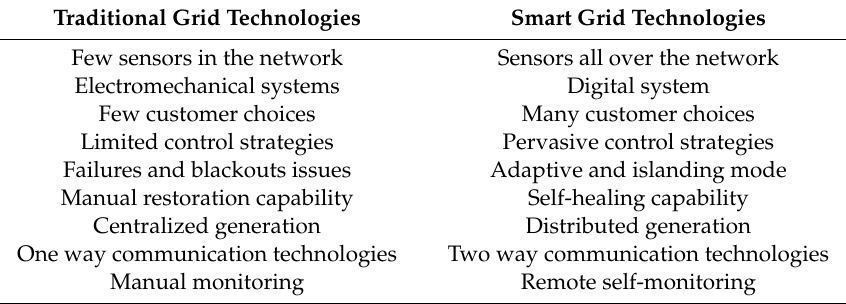
Table 1. Di ff erentiation between traditional grid and smart grid technologies [27–29]. Table 1. Differentiation between traditional grid and smart grid technologies [27–29].